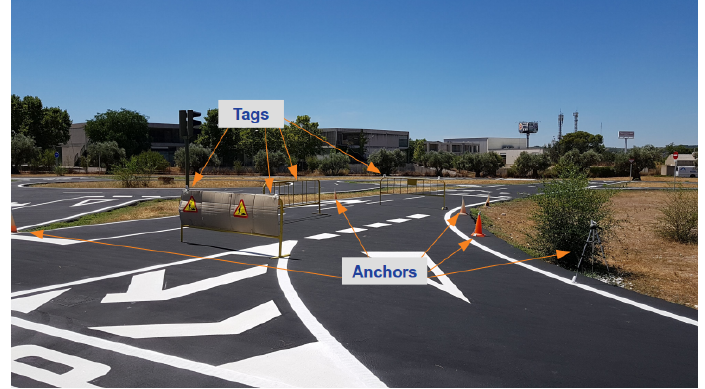
Figure 7. Scenario 1: Roadworks area and UWB